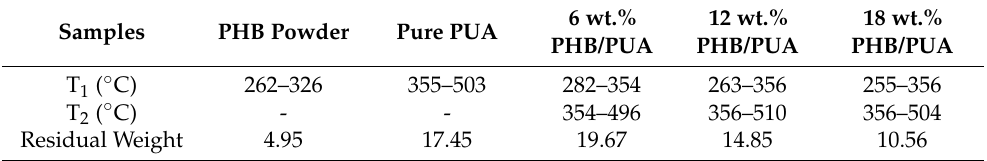
Table 5. Thermal decompositions and their correlation towards weight reduction (%) of samples.